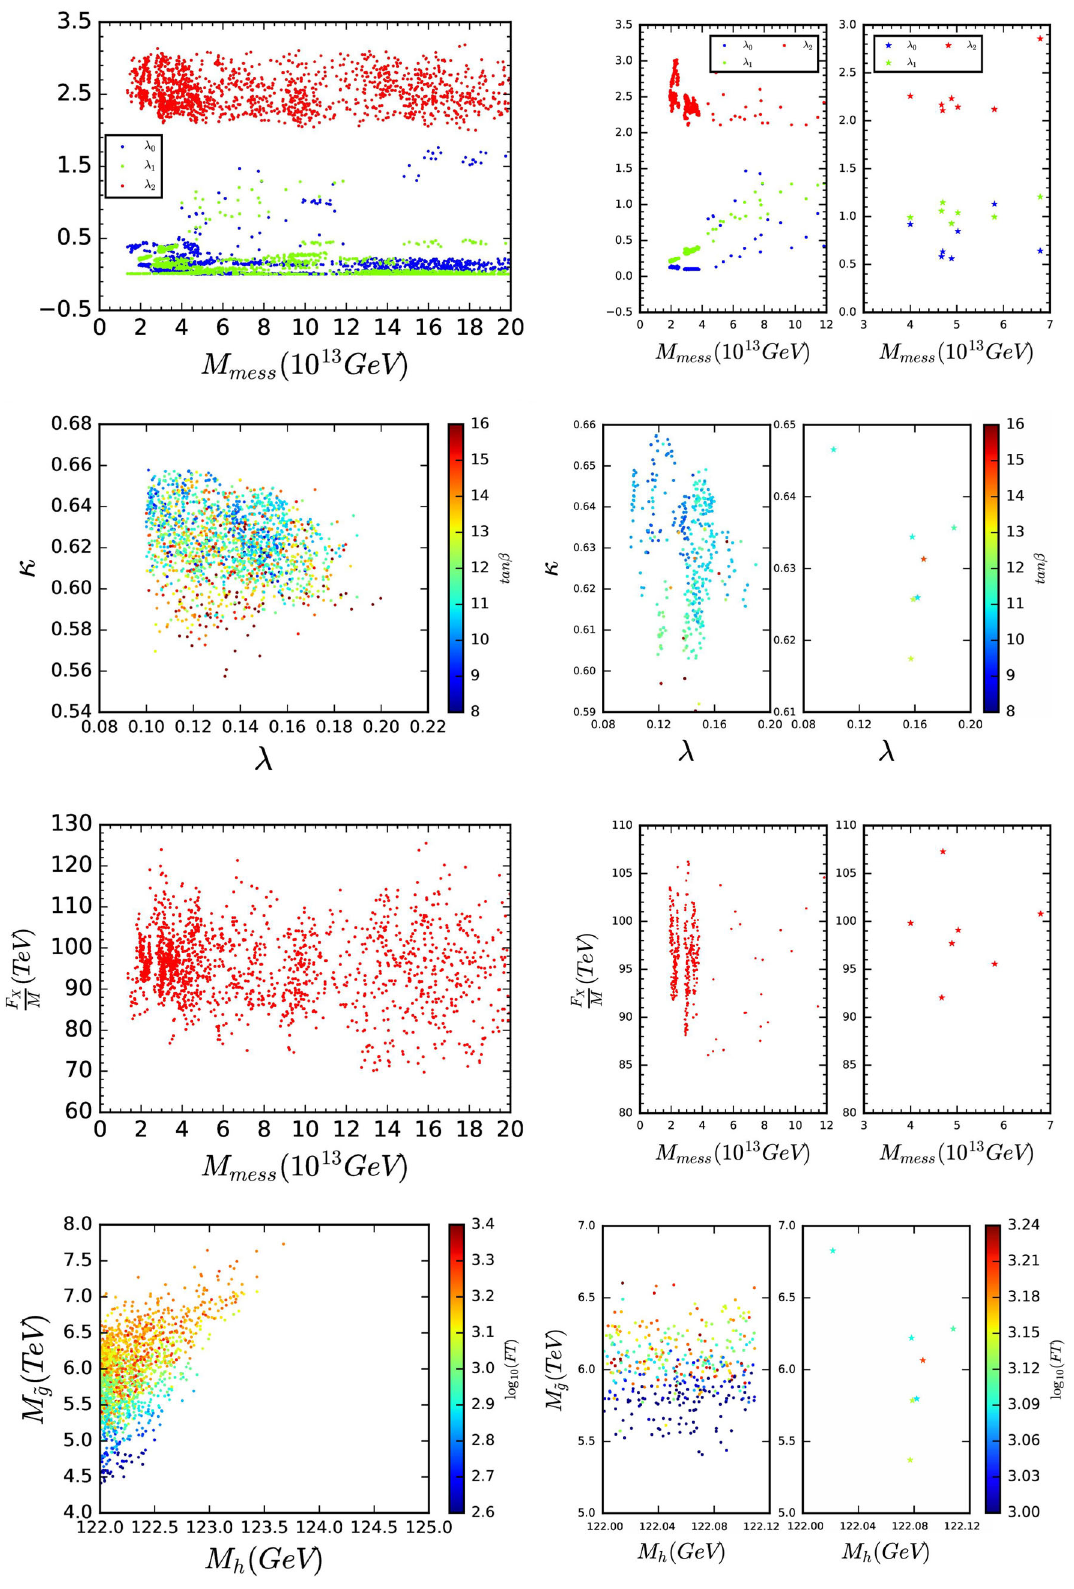
Fig. 1 Survived points that can satisfy the EWSB conditions and the constraints from (I) to (V) in type-II neutrino seesaw mechanism exten- sion of NMSSM from GMSB. The 125 GeV Higgs is found to be the lightest CP-even scalar for all the survived points. The BG fine tuning